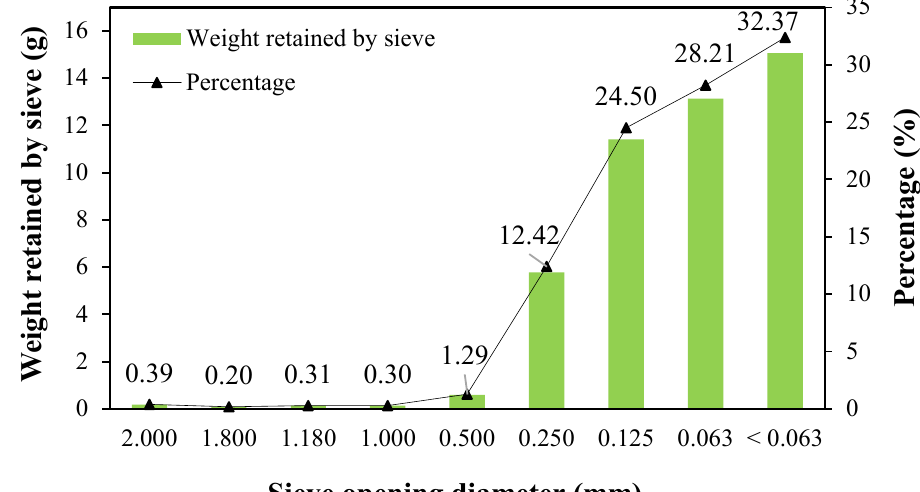
Figure 1. Particle diameter distribution.